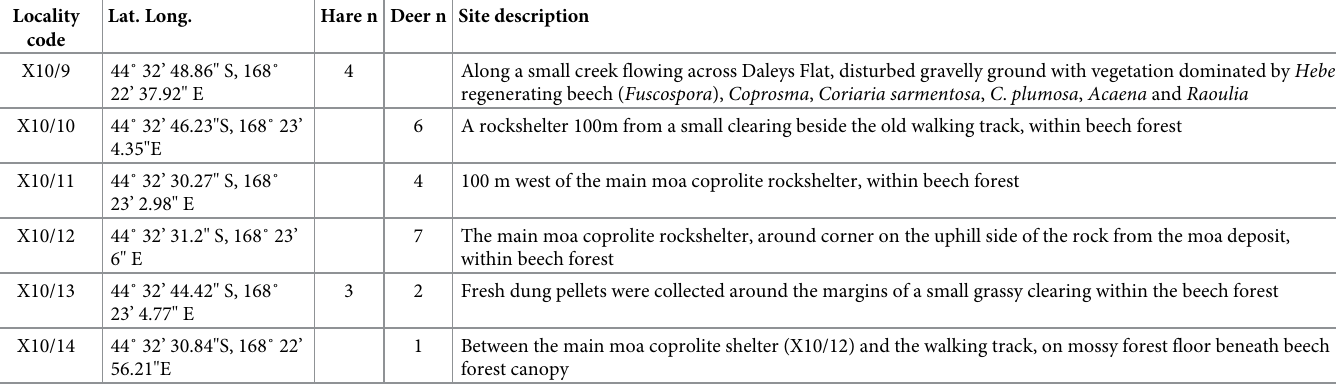
Table 1. Details of collection localities for deer and hare pellets, Dart River Valley, July 2010. Locality Lat. code